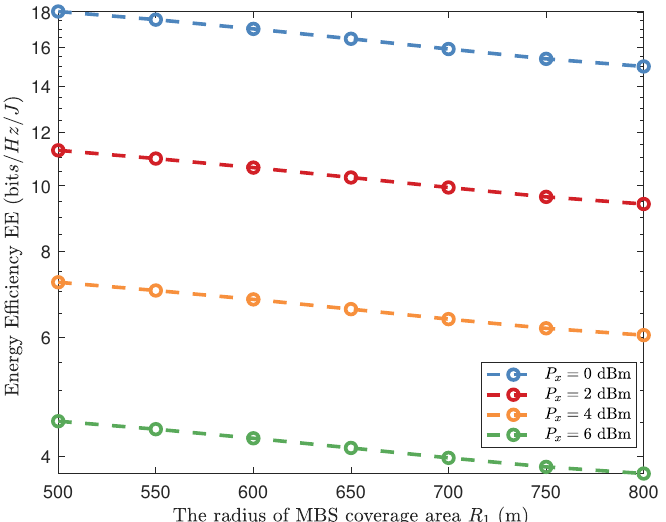
Figure 7. Energy efficiency of the network versus the radius of MBS coverage area R 1 with different transmit power of users P x . The SINR threshold is − 15